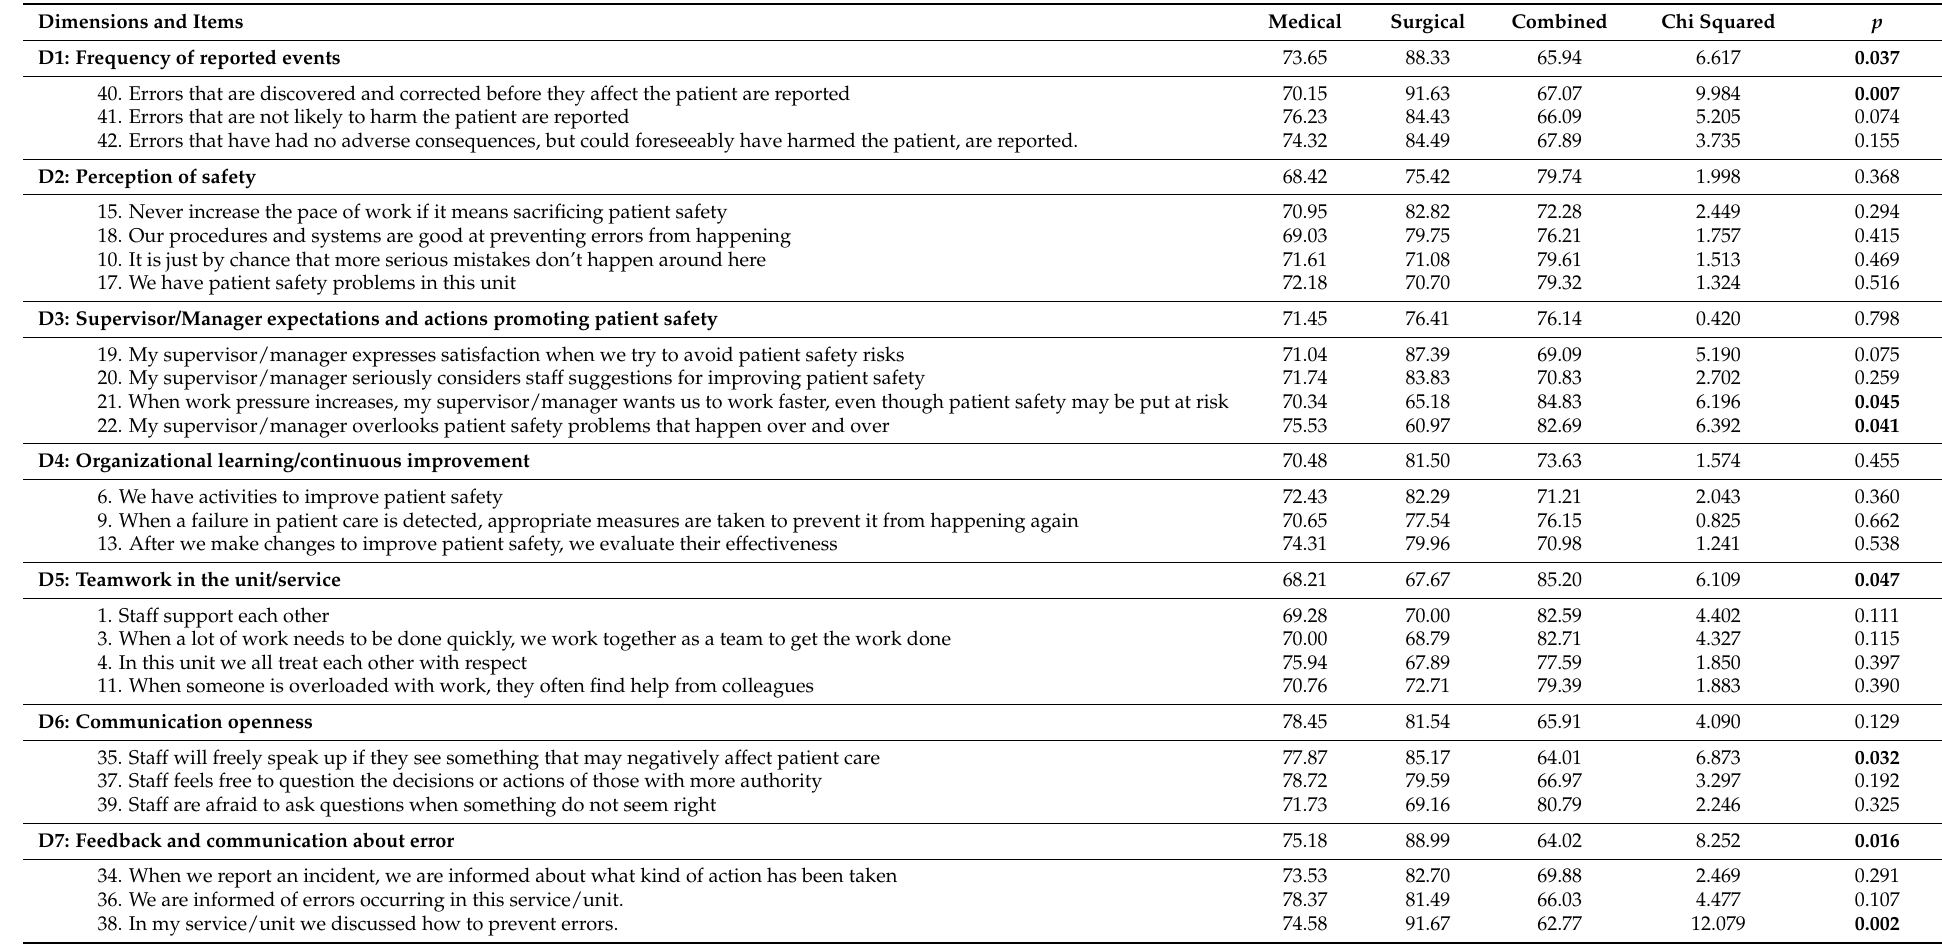
Table 3. Analysis by dimension, item, and unit